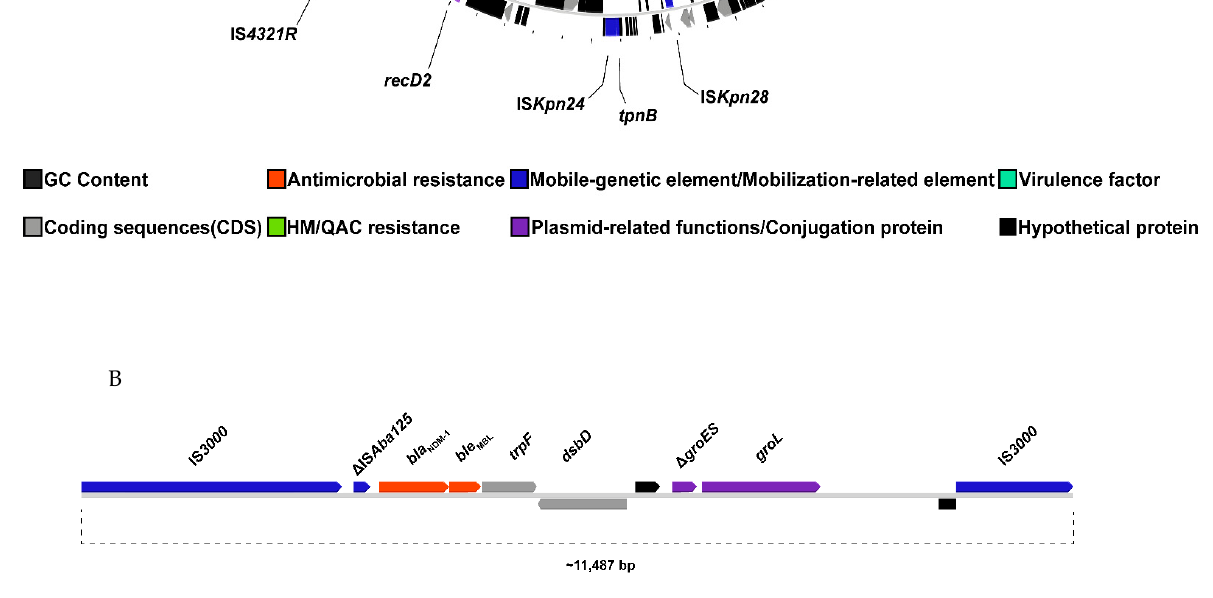
Figure 1. Circular representation of plasmid harboring bla NDM-1 in K. pneumoniae UCO-361. ( A ) Gen- eral representation of genes encoded by pNDM-1_UCO361 showing coding sequences (CDS) in black, mobile-genetic elements in green, antibiotic-resistance genes in red and plasmid replica- tion/conjugation proteins in blue. The genetic context of bla NDM-1 is highlighted inside the red box. ( B ) Linear view of Tn 3000 containing the bla NDM-1 gene. Figures were created with Proksee